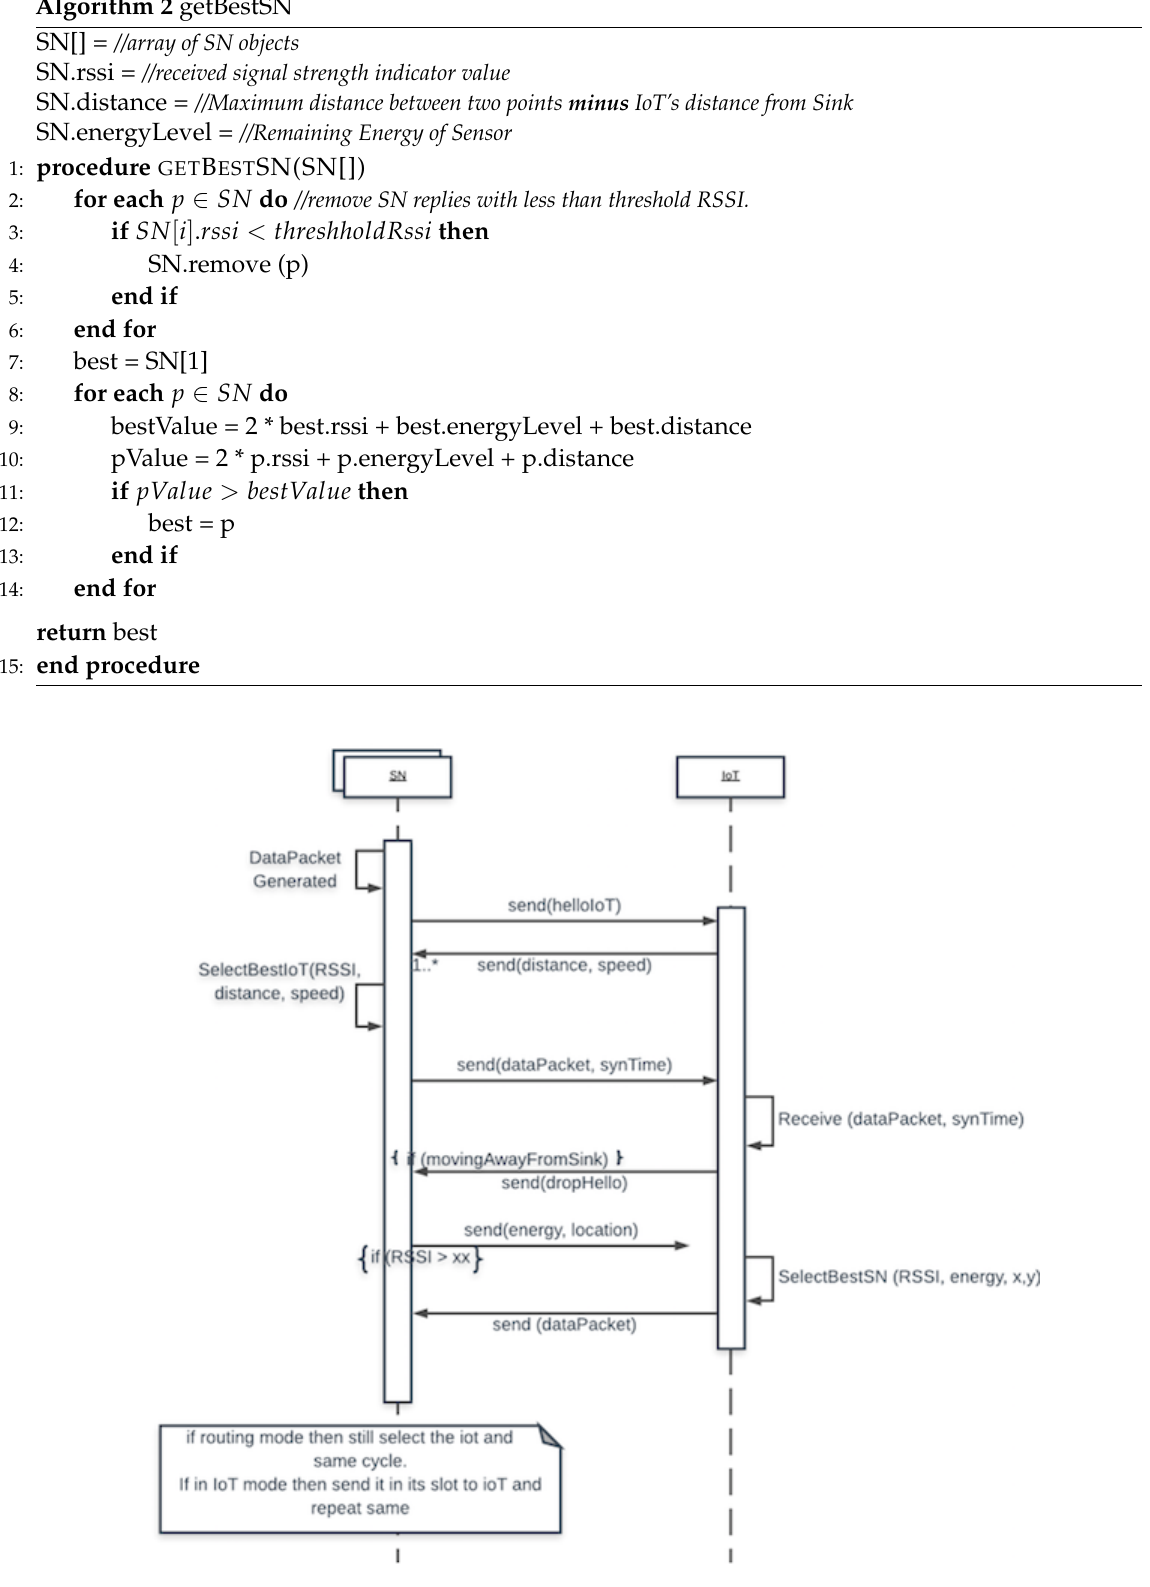
Figure 6. The communication steps between wireless sensor networks (WSN) and IoT layer